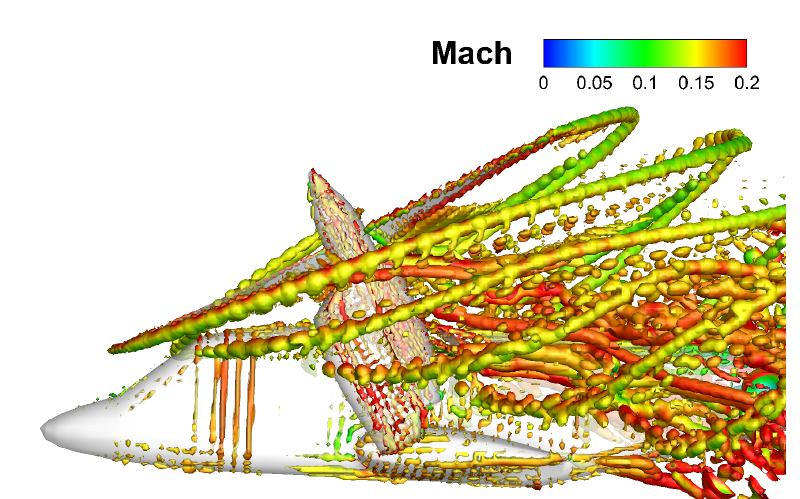
Figure 19. Instantaneous flow field that is computed by DUST in conversion flight condition at